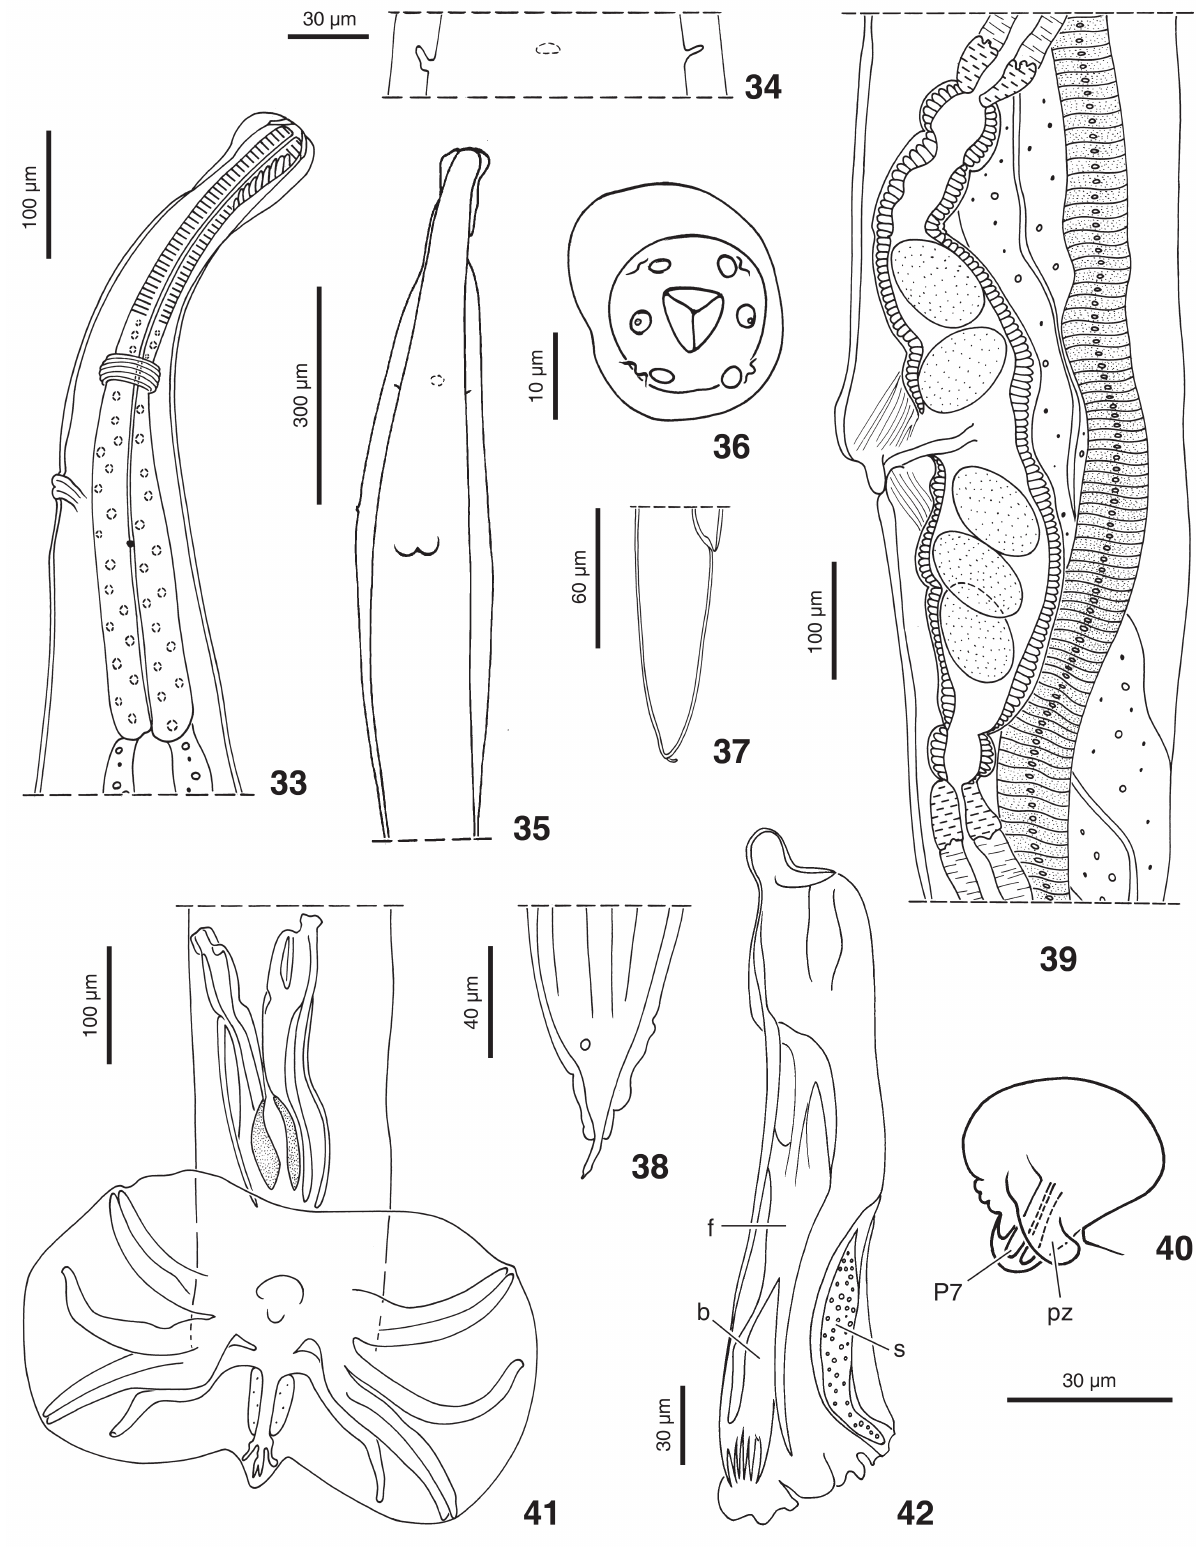
115-125Figs 33-42. – Oswaldocruzia fredi n. sp. 33-35. Holotype male. 33 - anterior extremity, left lateral view. 34 - detail of excretory pore and deirids, dorsal view. 35 - silhouette with cervical alae, dorsal view. 36-39. Female. 36 - head, apical view. 37 - tail, right lateral view. 38 - posterior extremity, disappearance of cuticular ridges, right lateral view. 39 - ovejector, left lateral view. 40-42. Male. 40 - genital cone, ventral view. 41 - caudal bursa, ventral view. 42 - right spicule, interno-ventral view. Abbreviations: f, fork; s, shoe; b, blade; pz, papilla zero; p7, papilla Parasite, 2006, 13 , Mémoire